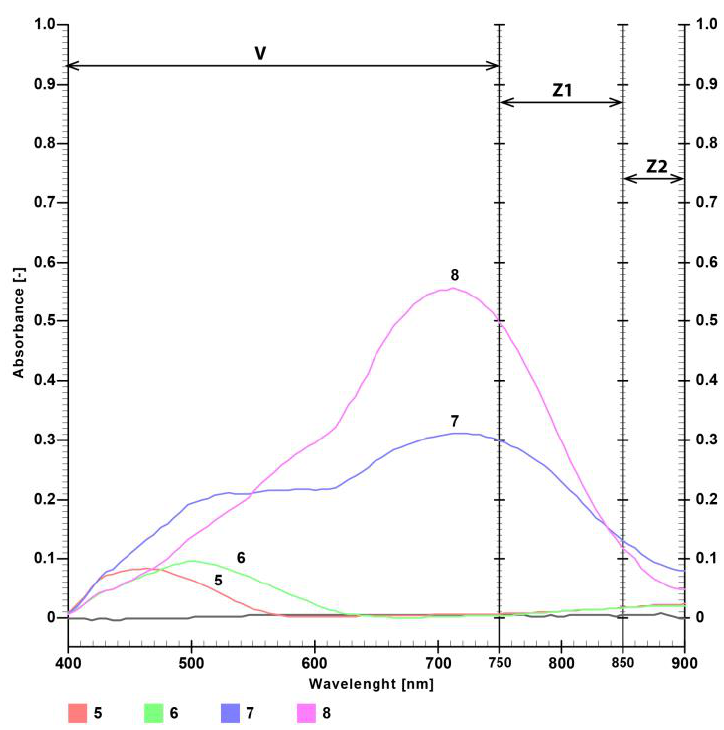
Figure 5. Dyes 5, 6, 7, and 8 (second row in Figure 1).